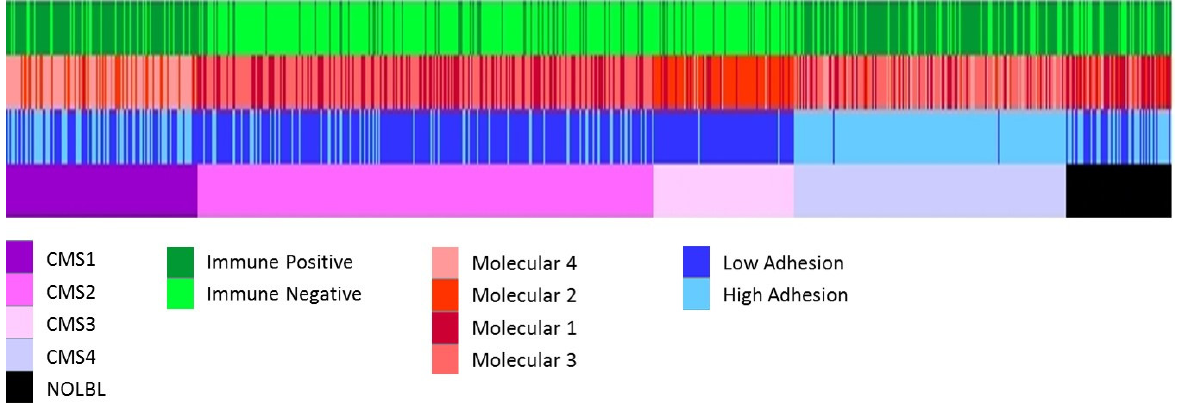
Figure 7. All the classifications of CRC tumors. From top to bottom, immune layer, molecular layer, adhesion layer, and CMS classification groups.